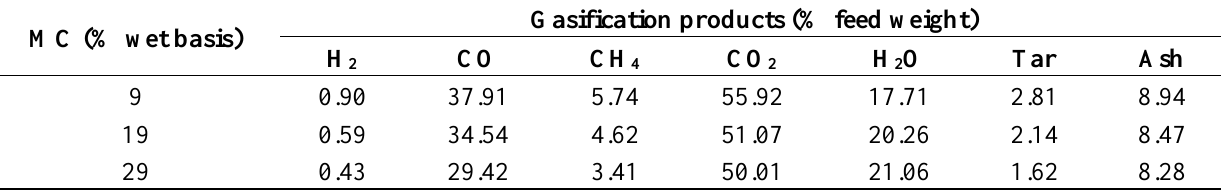
Table 7. Gasification products at various levels of switchgrass moisture content (MC) (adapted with modification from [49]).